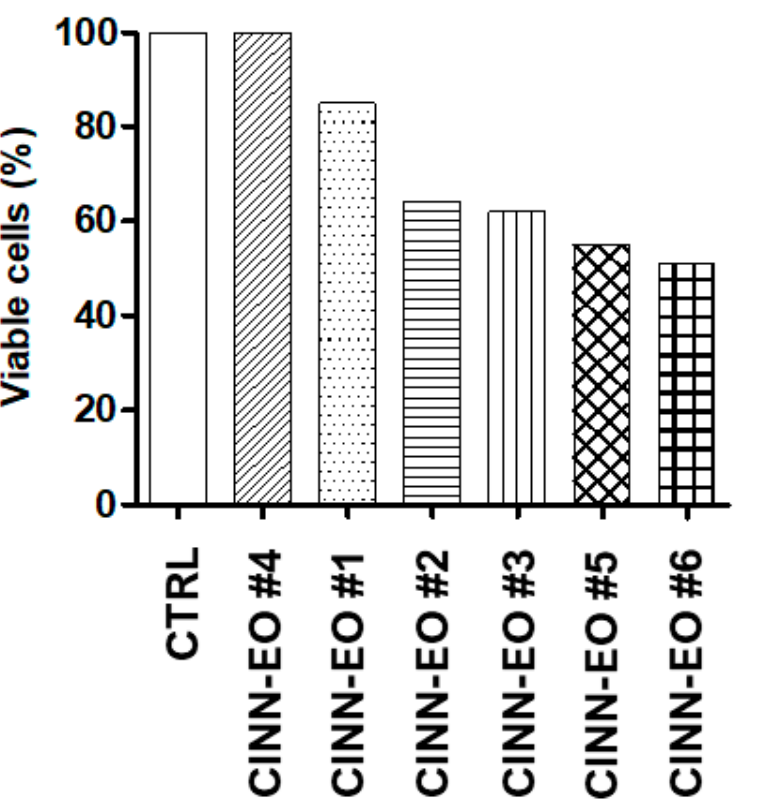
Figure 2. Dose–response effect of six different C. zeylanicum essential oils (CINN-EOs). All the CINN-EOs were used at the concentration of 10 µg/mL on M14 cells for 48 h. The number of viable cells after each treatment is reported as a percentage of the untreated control cells.